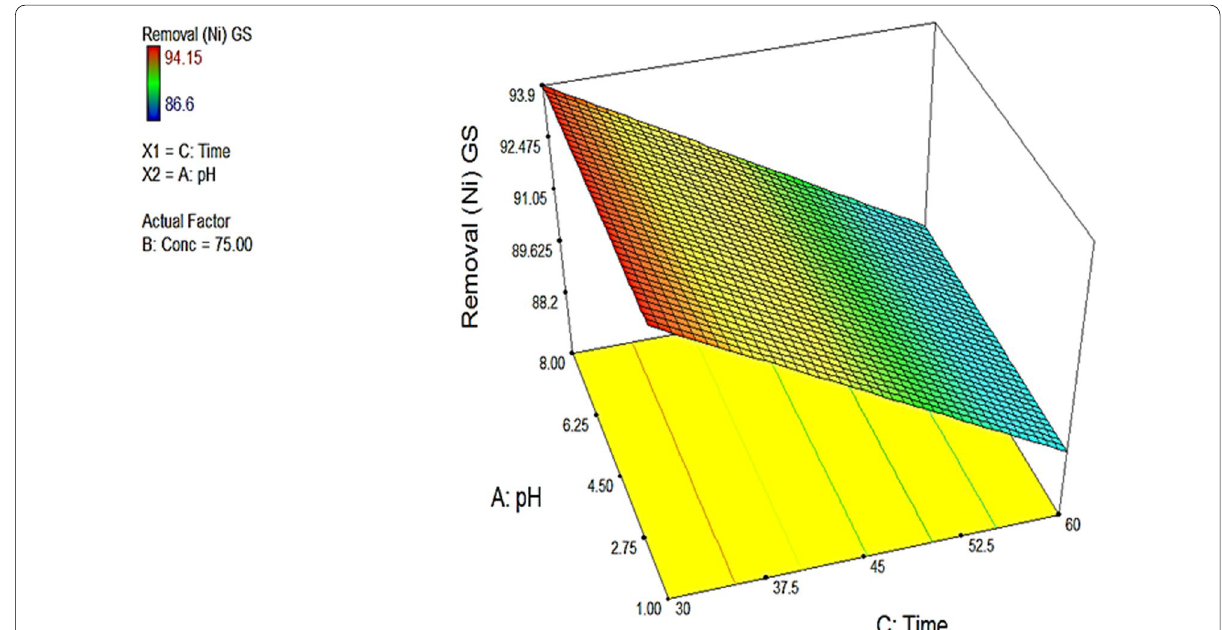
Fig. 12 A 3-dimensional plot of concentration and pH against the percentage removal of Nickel when groundnut shell residues are used as